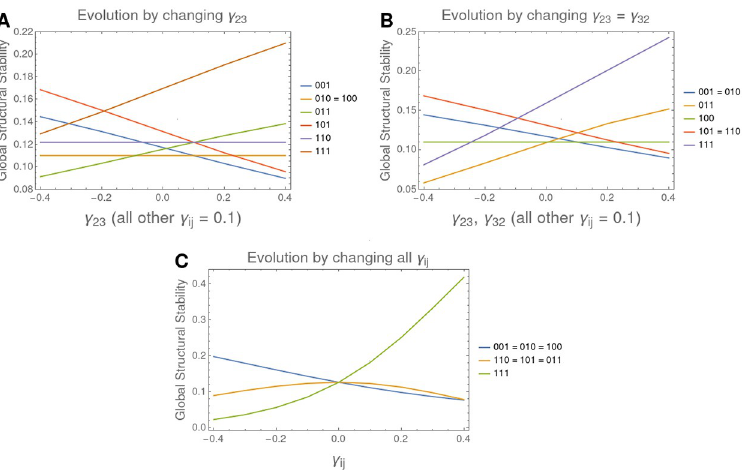
Fig 5. Evolution of global structural stability on parameters on a 3D LV system. A. We observe the evolution of the size of the cones when changing parameter γ 23 from competition (0.4) to cooperation values ( − 0.4). We observe that cones of maximal biodiversity ( u 111 ) and the cone associated to stationary point u 011 behaves monotonically increasing with γ 23 . B. The same result, now simultaneously changing γ 23 and γ 32 . Note that the cones for u 011 and u 111 now grow faster, while other cones with constant size now decreases (as those associated to u 010 and u 110 ). C It is shown the Global Structural Stability from a competitive system to a cooperative one, by changing all the parameters in matrix A . Note that, among all, it is the cone with maximal biodiversity the only one increasing with an income of cooperation in the system.